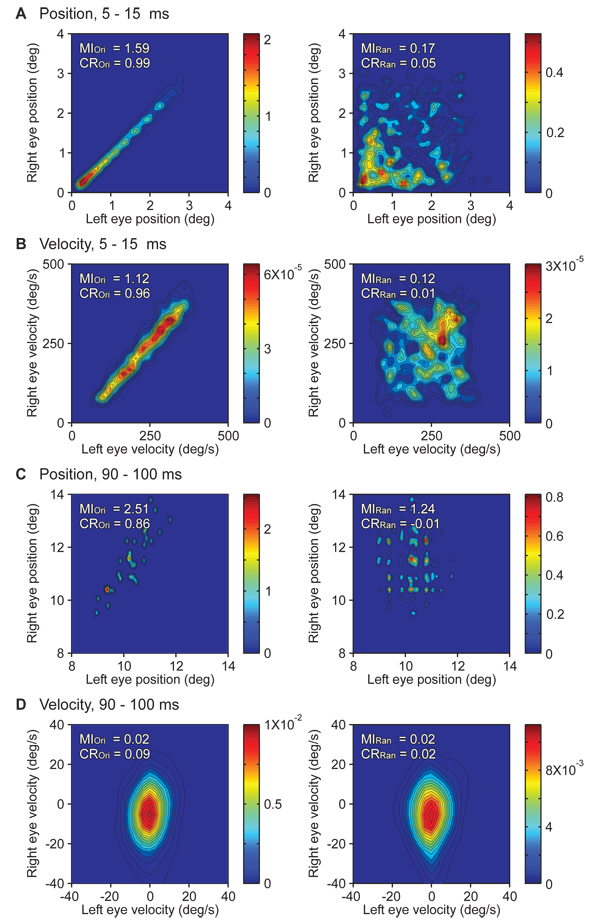
Examples of joint probability density distributions, used for computation of mutual information (MI). The distributions were estimated by applying a Gaussian kernel to: A. Eye position samples between 5 and 10 ms from saccade initiation; B. Eye velocity samples between 5 and 10 ms; C. Eye position samples between 90 and 100 ms; D. Eye velocity samples between 90 and 100 ms. The smoothing length of the kernel was optimized based on the samples by the likelihood cross validation method. The distributions are for a leftward saccade, Go/NoGo session on the 1st day. Left panel: The samples were paired between the eyes in each trial with no delay. The MI of the original paired samples (MIOri) and its correlation coefficient (CROri) are noted on the top left of each panel. Right panel: The pairs were randomized among trials within the time window of 11 ms. Because of the finite sample size (330 pairs). the MI of randomized samples (MIRan) was often significantly larger than zero in spite of the randomization procedure. The MIRan was used to estimate the overestimation of relationship. The CROri did not overestimate the relationship as shown by the correlation coefficient of the randomized samples (CRRan). The probability densities are indicated by the colors, as specified in the color scales. The units of velocity are (deg/s)-2 and position deg-2.